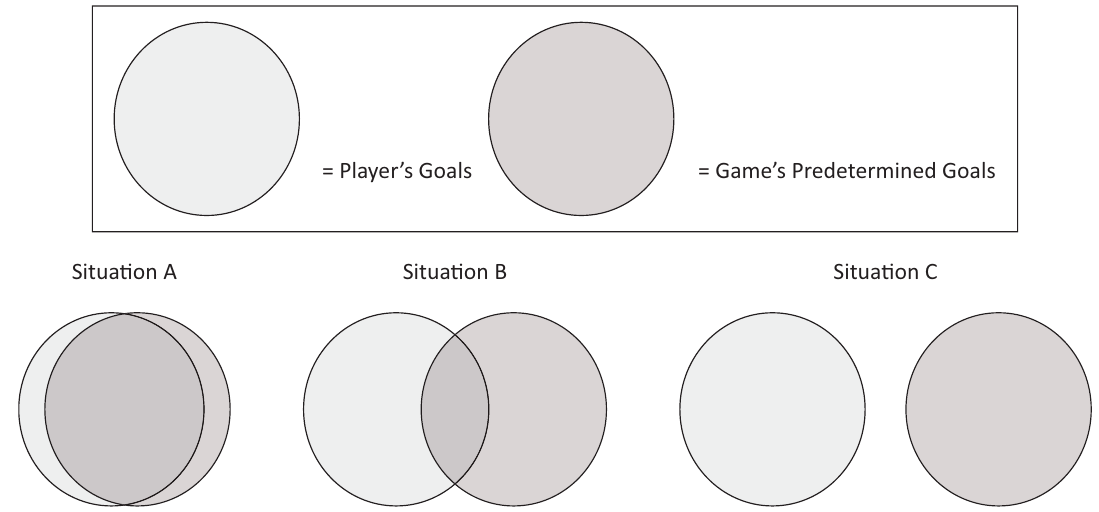
Figure 2. A visualization of players’ goals and game developers’ goals, and the various configurations of alignment or mis- alignment these can